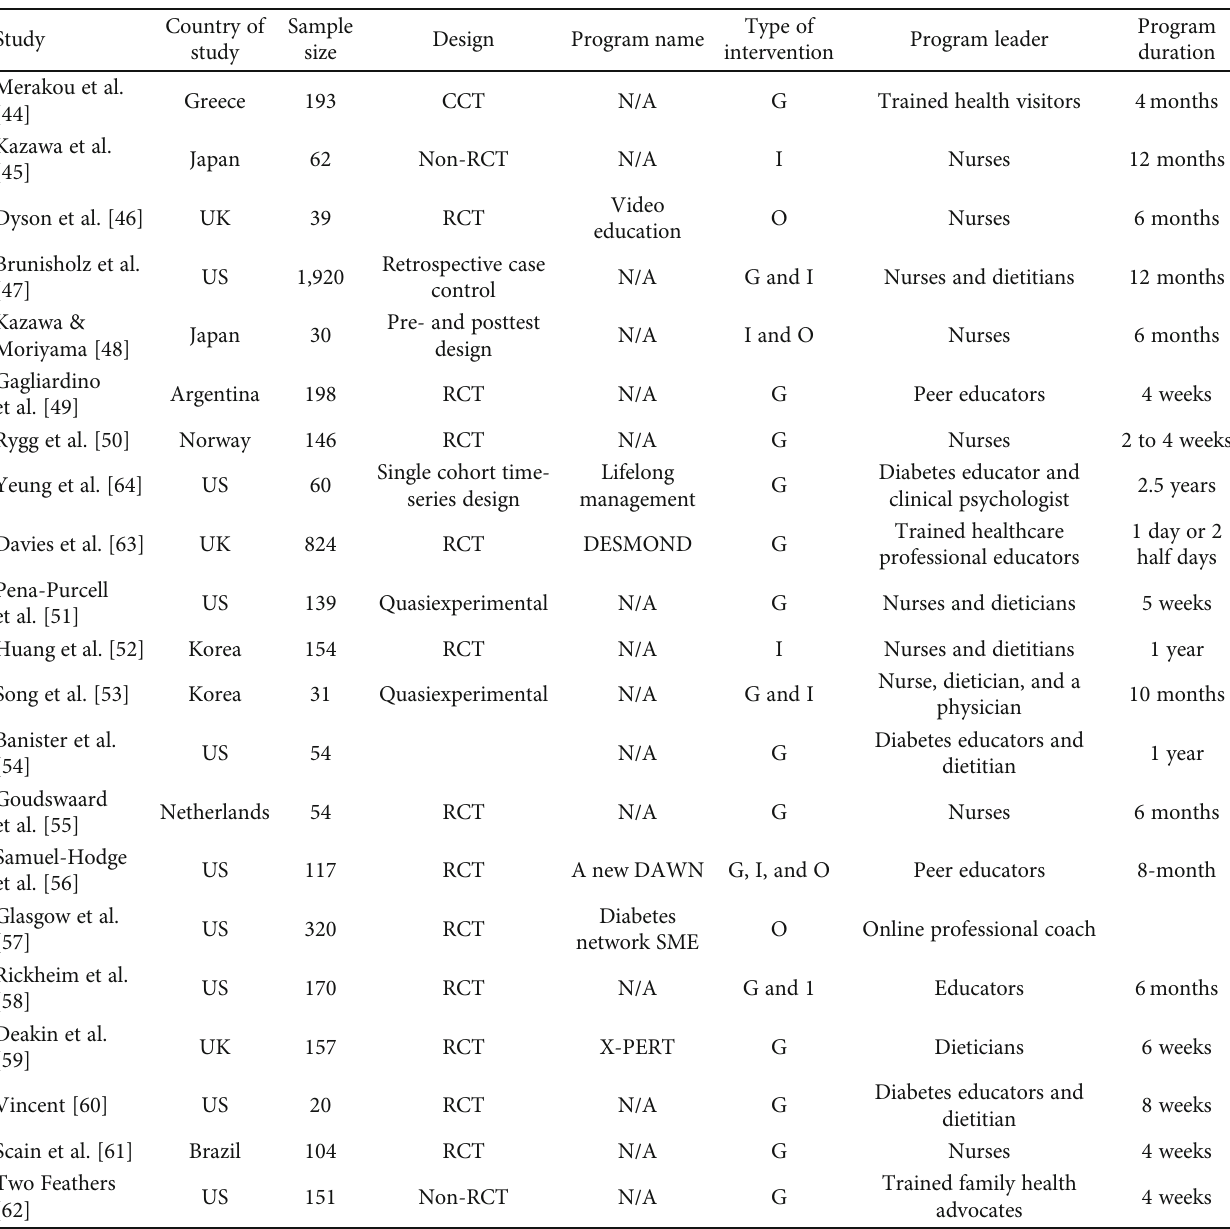
Table 2: Characteristics of selected